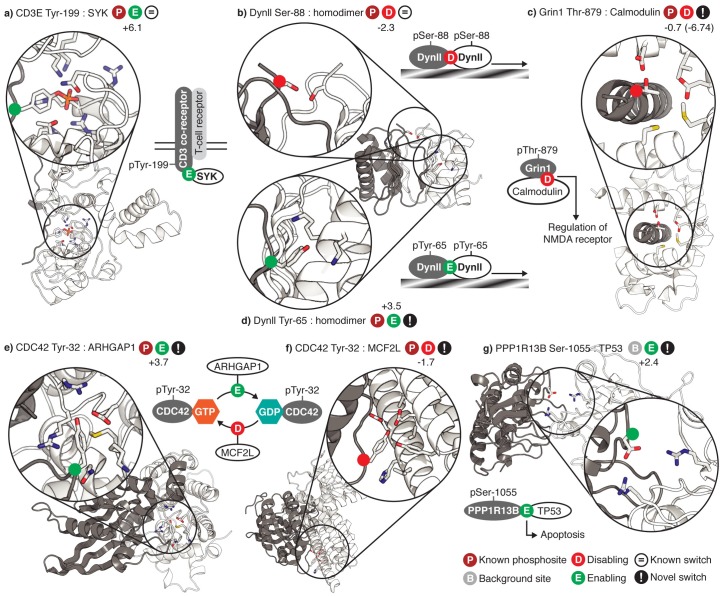
Gallery of phosphosites known or predicted to enable or disable protein interactions.Phosphorylated proteins are shown in grey and the proteins with which they interact are shown in white. The sidechains of phosphosites and the residues with which they interact are shown as sticks coloured by atom type. Phosphosites are indicated by coloured dots on C-alpha atoms. Sswitch scores are shown besides enabling or disabling symbols. a) Phosphorylation of Tyr-199 of an immunoreceptor Tyrosine-based activation motif of the CD3 T-cell co-receptor enables the interaction with Syk Tyrosine by interacting with several positively charged residues [37]. b) Homo-dimerisation of Dynein light chain is mediated by the phosphorylation of two copies of Ser-88 that are in contact in the homodimer interface. Phosphorylation of both copies of Ser-88 would lead to the repulsion of two negatively charged phosphate groups and is known to lead to the formation of inactive monomers (unable to move along microtubules) in preference to active dimers [40]. c) Phosphorylation of Thr-879 in Glutamate receptor subunit zeta-1 (GRIN1) is predicted to disable interaction with Calmodulin, and therefore affect regulation of the NMDA receptor [42], since it lies in a highly negatively charged interface (PDB 3bya, to be published). This has a high negative IE (-6.74) but is poorly conserved (fCons = 0.1) resulting in an Sswitch of -0.7, below the threshold. d) The Tyr-65 phosphosite of human Dynein light chain strongly enables the formation of the Dynein homodimer by interacting with at least two positively charged lysine residues on the opposing face. This enabling effect is doubled because the homodimeric interface is symmetrical [39]. e) Phosphorylation of Tyr-32 of human CDC42, a small GTPase, enables an interaction with GTPase activator ARHGAP1 through contacts with predominantly positively charged residues [43] and f) disables an interaction with guanine nucleotide exchange factor MCF2L, since MCF2L residues in contact with Tyr-32 carry a net negative charge, shifting the CDC42 towards its inactive GDP-bound form. The CDC42-MCF2L interaction was modelled on a crystal structure of a human CDC42 homologue interacting with mouse guanine nucleotide exchange factor DBS [44]. g) The crystal structure of Apoptosis-stimulating of p53 protein 2 (53BP2) interacting with TP53 [45] predicts that phosphorylation of Ser-1055 in the Apoptosis-stimulating of p53 protein 1 (PPP1R13B), which is Aspartate in 53BP2, will enable its interaction with TP53 by interacting with Arg-273 and Arg-248, two arginines which are highly mutated in many human cancers [45].